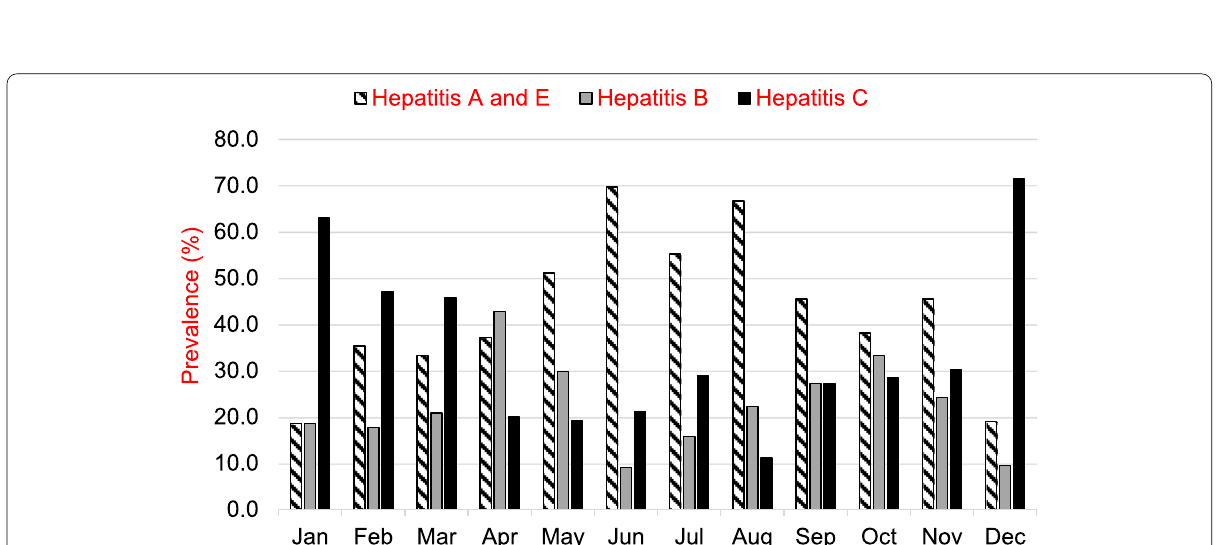
Fig. 2 Monthly comparative (relative) percentage prevalence of different types of viral hepatitis in indoor patients in the District Dera Ismail Khan in